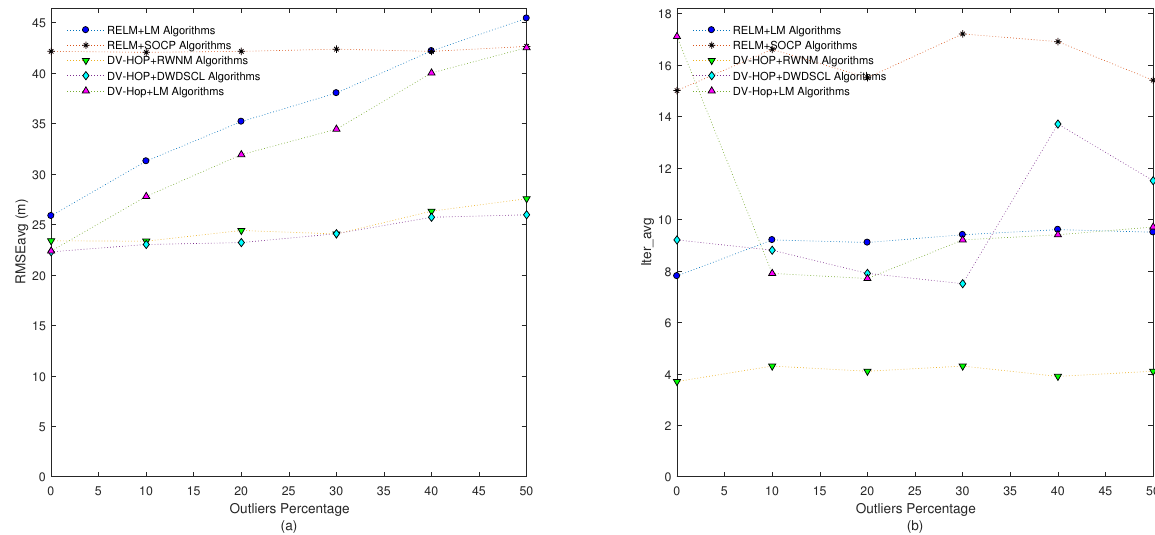
Figure 4. ( a ) RMSEavg and ( b ) Iter _ avg after running five iterative algorithms over 10 multi-hop isotropic networks with R = 35 m and nfe = 0.3. Outliers levels are increased by steps of 10% from 0% to 50%.